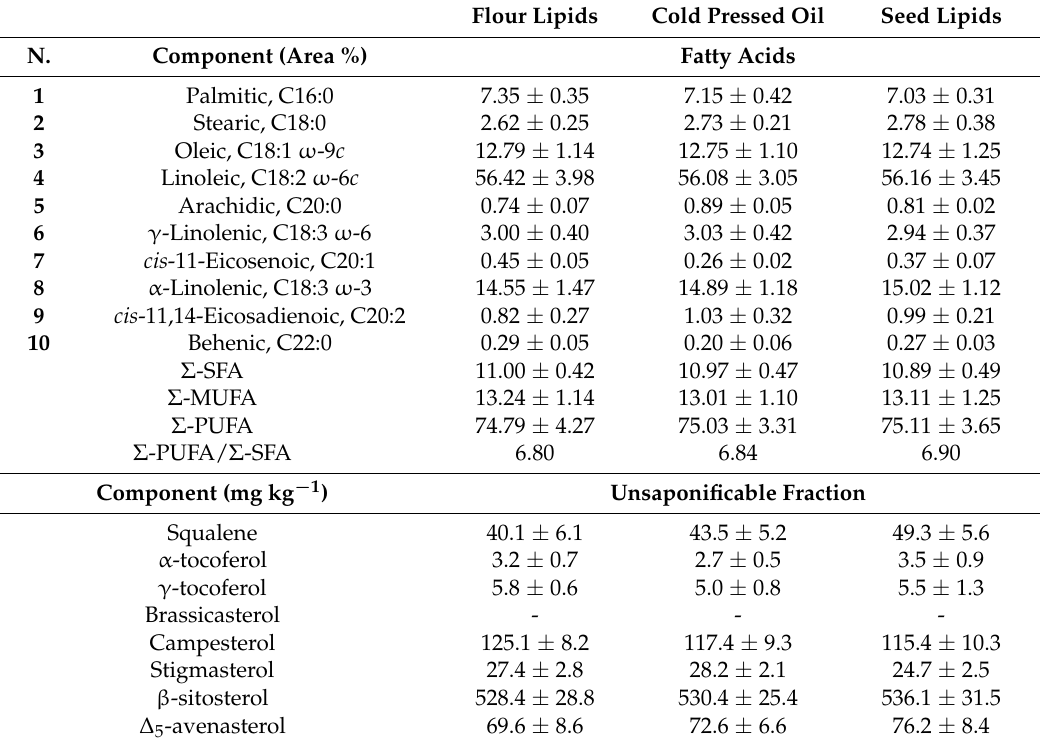
Table 2. Composition of fatty acids and unsaponifiable components in lipid extracts from hemp edible products ( Fedora cv). Flour Lipids Cold Pressed Oil Seed Lipids N. Component (Area %) Fatty